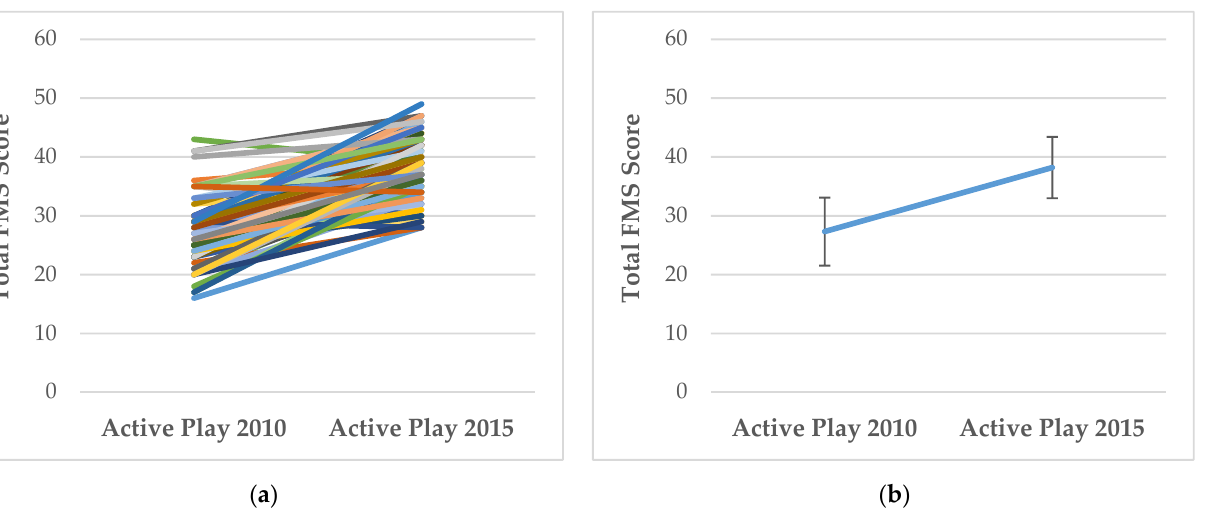
Figure 1. ( a ) Individual changes in total FMS scores between Baseline (Active Play 2010) and Follow- Up (Active Play 2015); ( b ) Mean (±SD) changes in total FMS scores between Baseline (Active Play 2010) and Follow-Up (Active Play 2015).